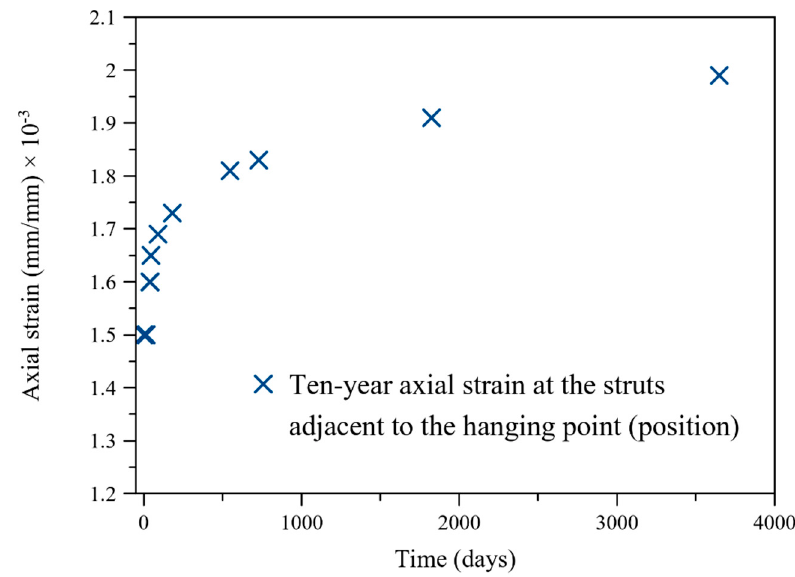
Figure 5. Ten-year (3650 days) time-dependent axial strain of the WPC strut adjacent to the hanging position of the cage structure. Table 2. Convergence study of the total number of elements (at two different time increments t) of the structure based on the long-term axial strain ( ε ) and the axial stress ( σ ) at the strut adjacent to the hanging point as shown in Figure 4C at given time values. Units of axial stress are MPa and the units of strain are (mm / mm × 10 − 3 ). Number of Elements of the Structure t = 0.125 Day Time (Years)